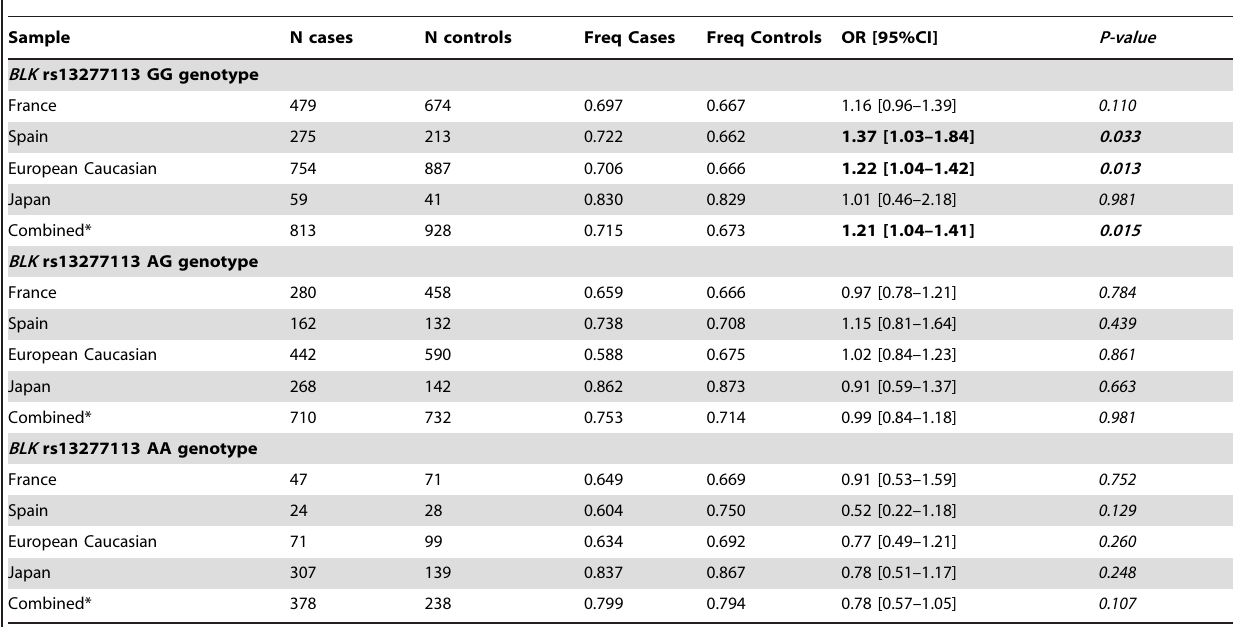
Table 2. Epistasis between BANK1 rs3733197 and BLK rs13277113 in rheumatoid arthritis: association of BANK rs3733197 G allele and BLK rs13277113